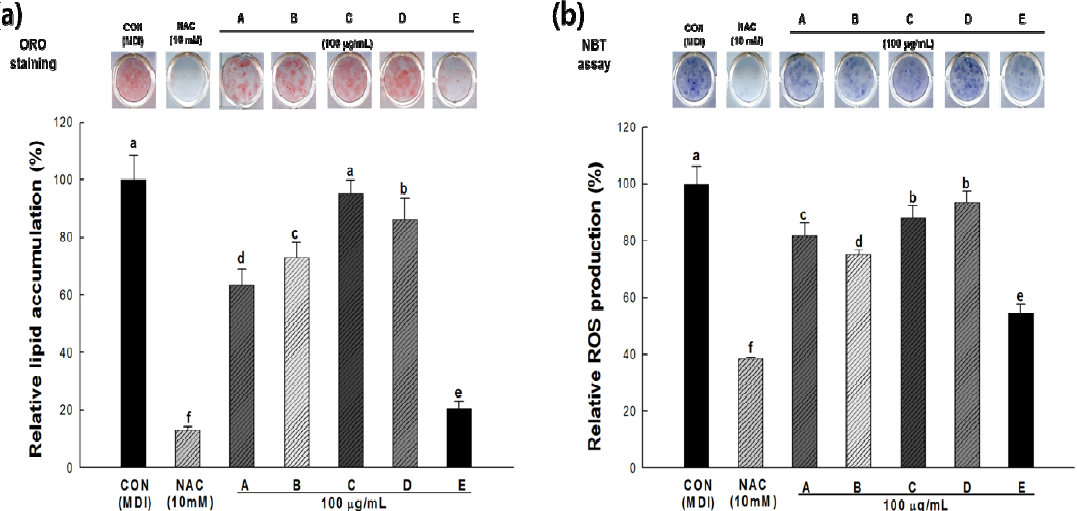
Figure 4. Effect of the five wild herb extracts on lipid accumulation ( a ) and reactive oxygen species (ROS) production ( b ) in 3T3-L1 cells during the adipogenesis. Accumulated lipids were stained with Oil Red O reagent and measured based on the absorbance at 490 nm. ROS production was assessed based on the formation of dark-blue formazan and determined by the NBT assay at a wavelength of 570 nm. CON, control cells which were differentiated with MDI; NAC, positive control cells which were differentiated with MDI in the presence of NAC; A–E, cells which were differentiated with MDI in the presence of each sample; A, Aster scaber ; B, Ligularia fischeri ; C, Kalopanax pictus ; D, Codonopsis lanceolata ; E, Cirsium setidens . All values are presented as the means ± SD. Bars with different letters indicate statistically significant differences among groups at p < 0.05 by one-way